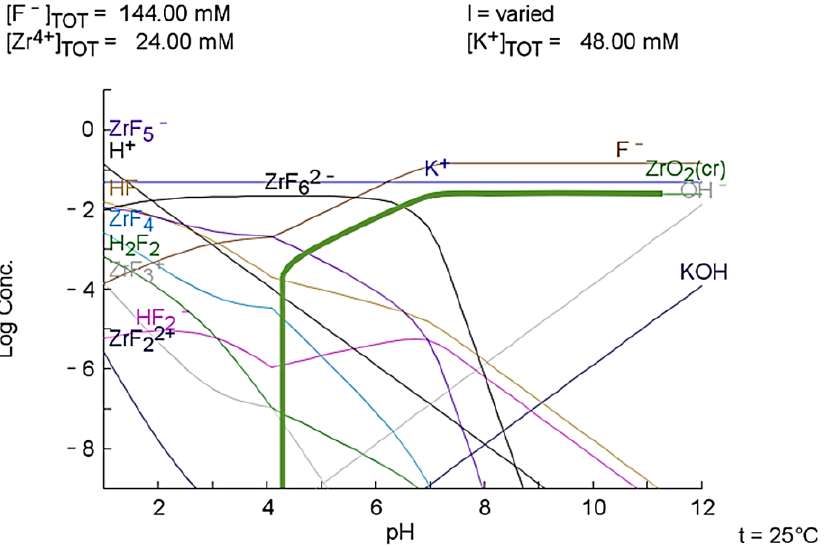
Figure 6. Simulated plots of the aqueous chemistry in the 0.024 M K 2 ZrF 6 solution at room temper- ature.